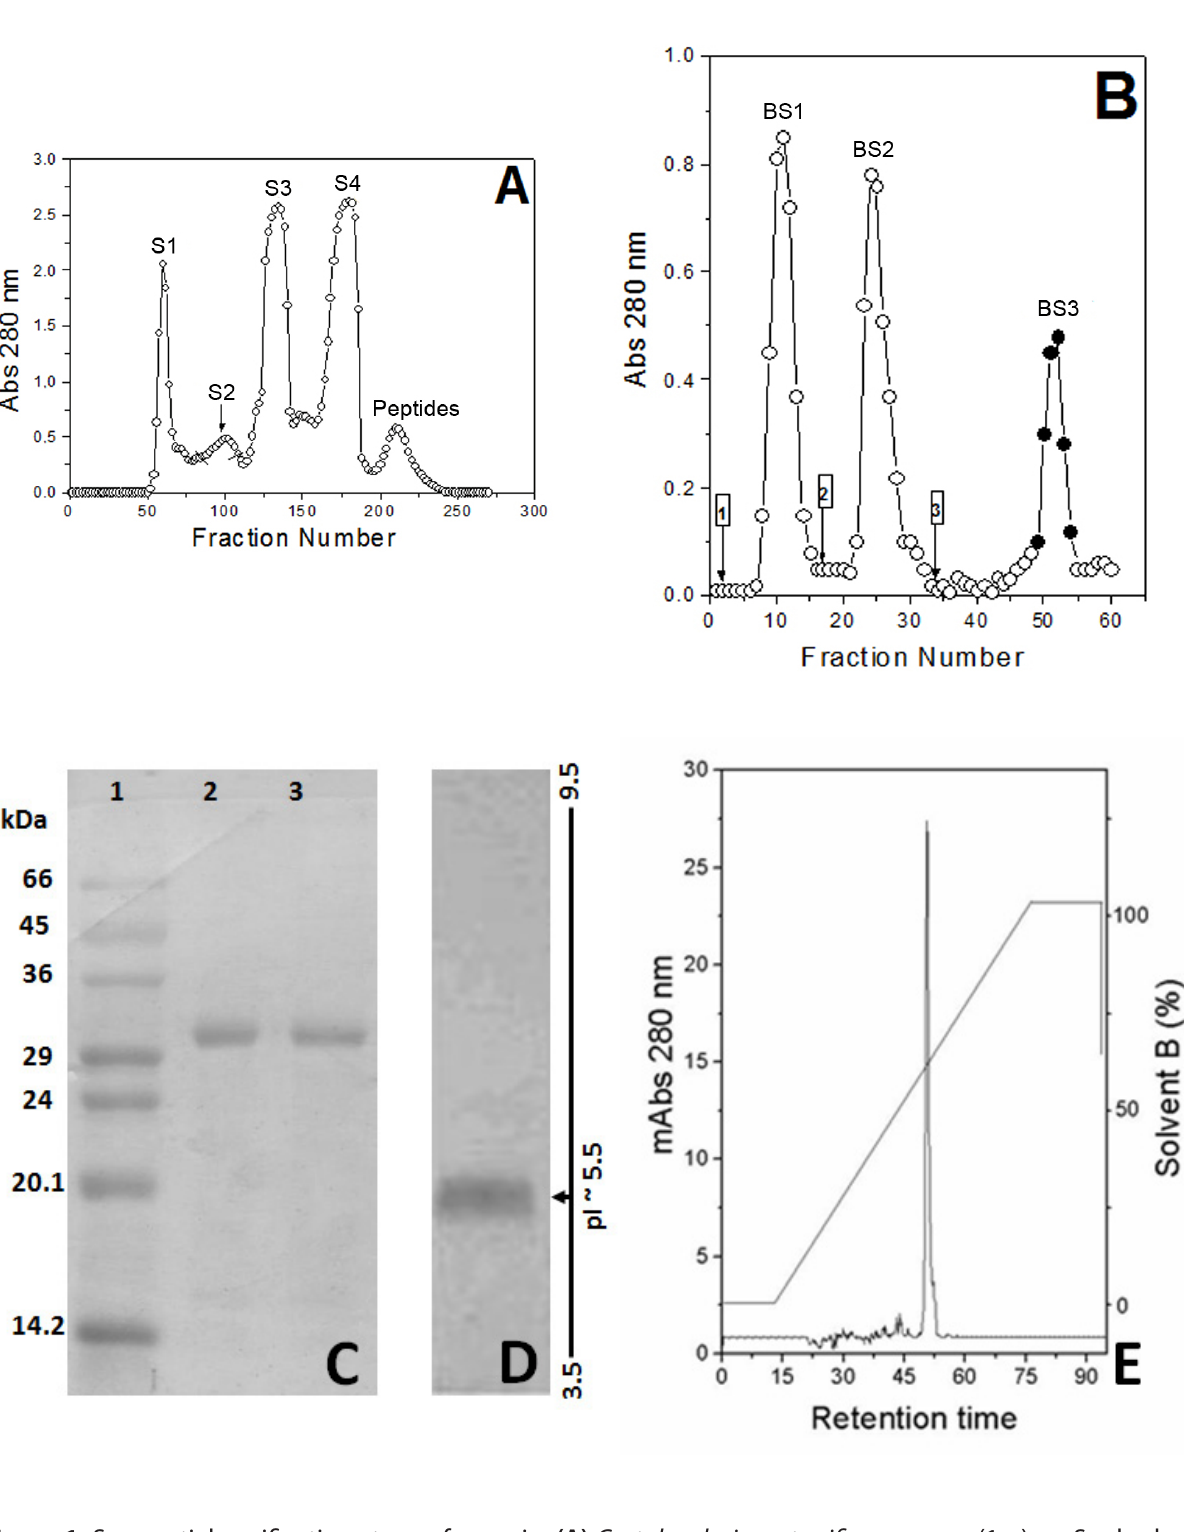
Figure 1. Sequential purification steps of gyroxin. (A) Crotalus durissus terrificus venom (1 g) on Sephadex G-75, in 0.05 M ammonium formate buffer, pH 3.5. Fractions of 10 mL/tube were collected at a flow rate of 30 mL/hour. (B) The active coagulant fraction, denominated S2 (100 mg), was rechromatographed on a Benzamidine Sepharose 6B column (8.5 x 2.5cm) previously equilibrated with 0.05 M Tris-HCl, pH 7.4 plus NaCl 0.5 M (solvent A) at room temperature and then eluted with 20 mL of glycine 0.02 M, pH 3.2 (solvent B), ending up with 400 µL of Tris-HCl 1.0 M pH 9.0. (C) Analysis of BS3 (gyroxin) by RP-HPLC using a C2/C18 column of 4.6 x 100 mm (Shimadzu, Japan), equilibrated with solvent A (0.1% trifluoroacetic acid and 5% acetonitrile) and eluted with a concentration gradient of solvent B (60% acetonitrile, 0.1% trifluoroacetic acid) from 0 to 100% at a flow rate of 1 mL/minute at room temperature. (D) SDSPAGE (13.5%) of gyroxin. Lanes: (1) molecular mass markers, (2 and 3) purified gyroxin. (E) pI determination for gyroxin, pI~